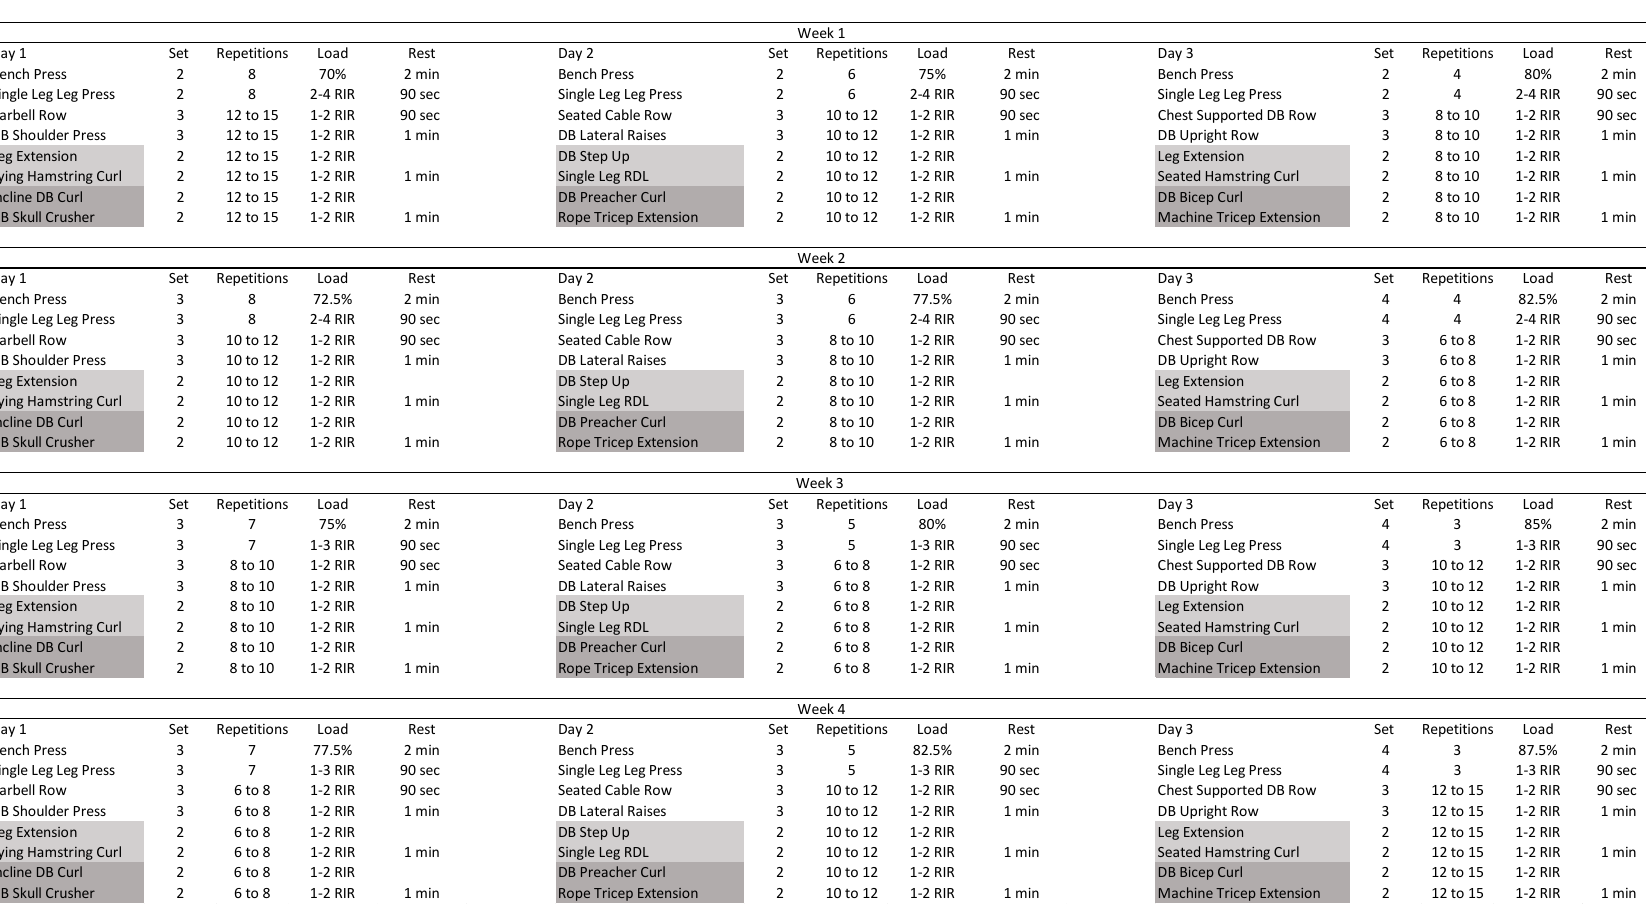
Figure 2. 4-week resistance training program; All percentages were based off estimated 1RM at pretesting. RIR = Repetitions in Reserve; DB = Dumbbell; RDL = Romanian Deadlift; Sec = Seconds; Min = Minutes.